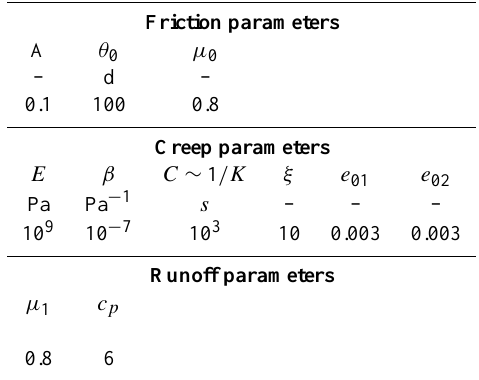
Table 1. Numerical values of parameters used in our